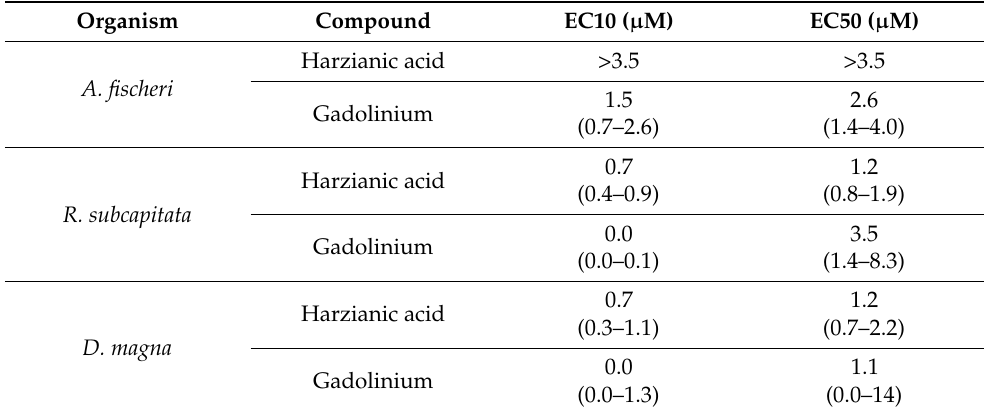
Table 4. Effective concentration at 10% (EC10) and median effective concentration (EC50) of gadolin- ium and harzianic acid for A. fischeri , R. subcapitata, and D. magna ; EC values are provided as averages ( n = 3), and values in brackets represent ± 95% confidence